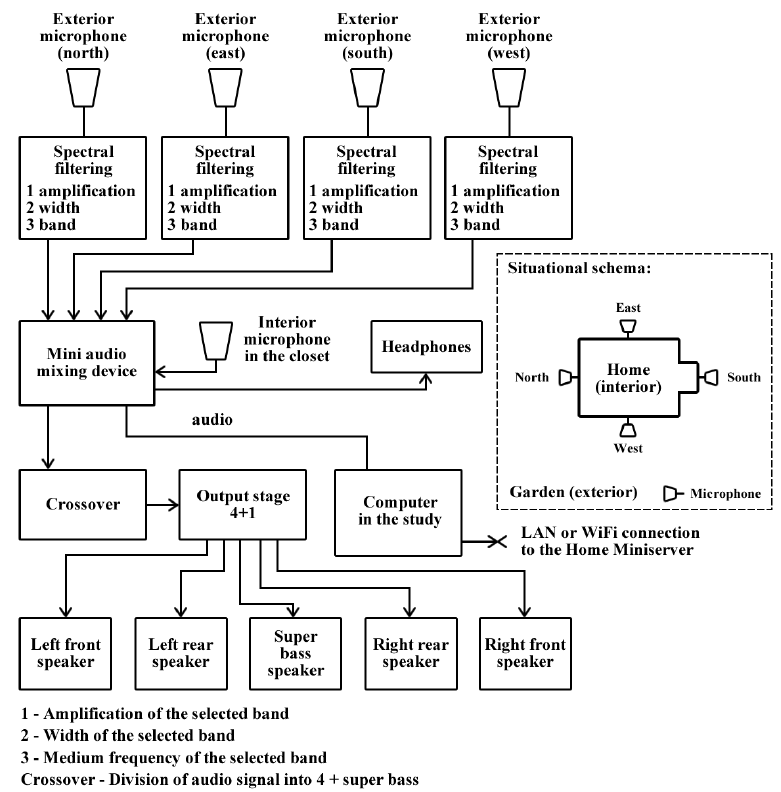
Figure 3. Block diagram of the Device Used for Supervising Children Outside (playing in the garden).